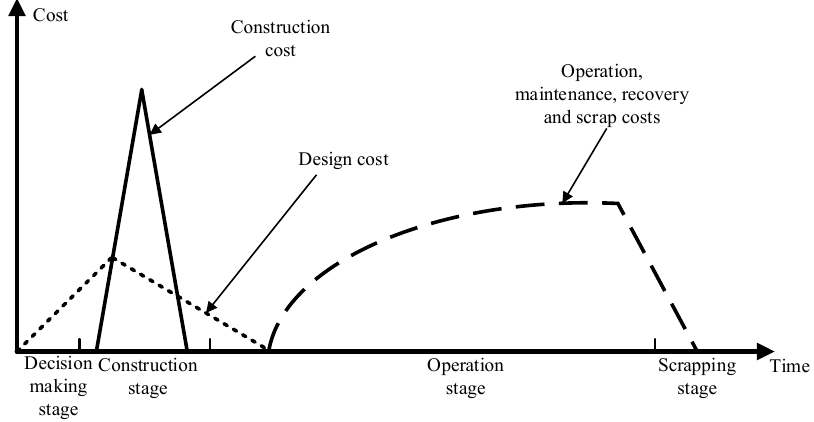
Figure 1. Diagram of cost trend at each stage of the life ‐ cycle.